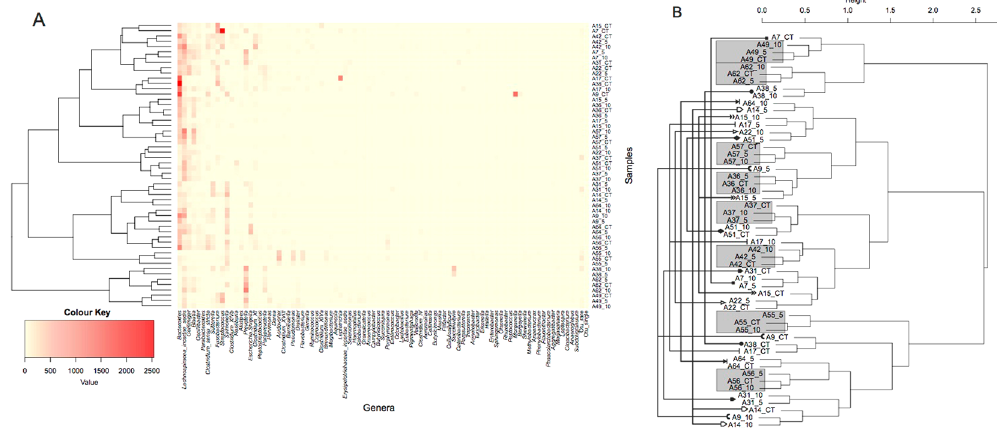
Figure 2. ( A ) Heatmap and ( B ) Clustering dendrogram (Bray-Curtis and Ward linkage) for genus-level OTU data. Figure A. demonstrates that three clusters of mucosal bacteria predmoninate and that on and off cancer samples appear to cluster together. In ( B ) the grey boxes highlight samples taken from tumour, 5 cm off tumour and 10 cm off tumour from the same individuals which cluster together. This shows that 8 out of 18 patients demonstrated significant homogeneity in mucosal bacteria on cancer and at 5 and 10 cms. This clustering effect is greater than any clustering associated with sampling location, suggesting that individual variation is a greater influence on CRC microbiome dysbiosis than colonic geographical sampling site relative to the tumour.